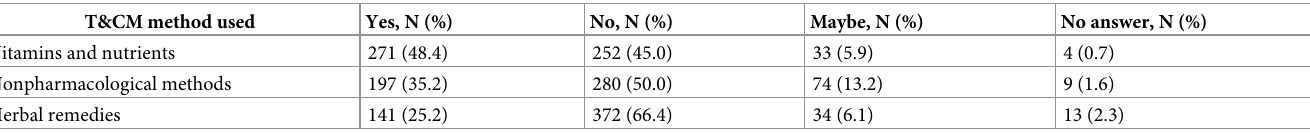
Table 2. Frequencies of using different T&CM methods for COVID 19 prophylaxis by health professionals. T&CM method